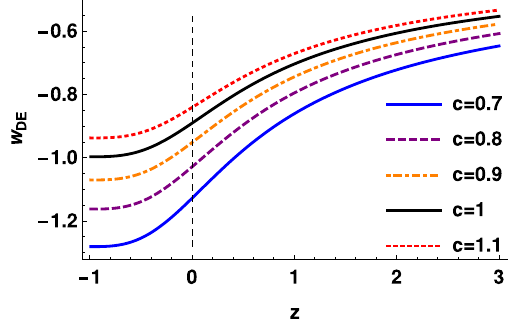
Fig. 2 The redshift-evolution of the equation-of-state parameter w DE of Kaniadakis holographic dark energy, for fixed K = 0 . 1 and various values of c . We have imposed (cid:8) DE 0 ≈ 0 . 7 and we have added a vertical dotted line marking the present time z = 0